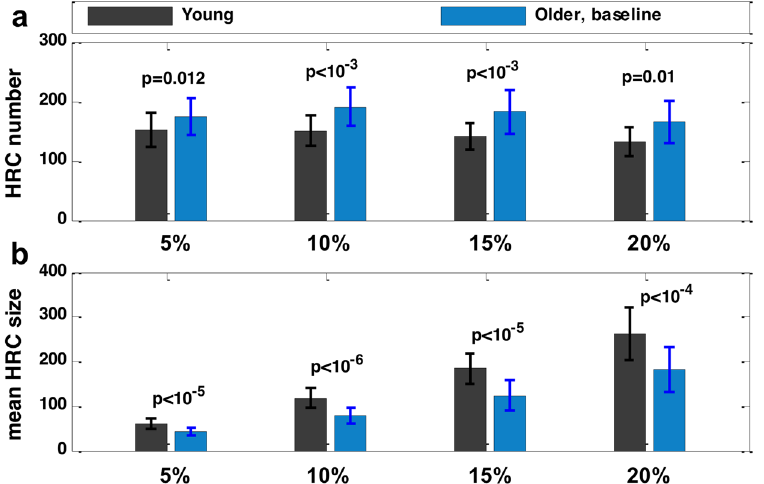
Figure 3. ( a ) HRC number and ( b ) average HRC size of young and older participants. HRC number and average HRC size were calculated under four different ReHo thresholds. The error bars indicate standard deviation. P-values were from two-sample, two-sided t-tests. Potential confounding factors (gender, education, FD) were corrected.